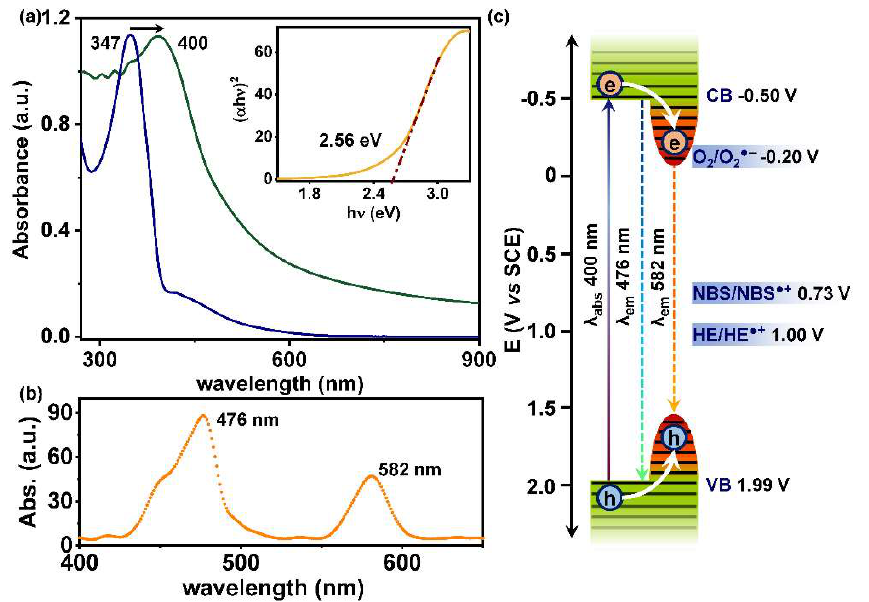
Figure 3. ( a ) The UV-Vis absorption spectra of the azo-monomer (blue) and AzoCPP (green) demon- strating the redshift in absorption maxima and corresponding Tauc plot (inset); ( b ) fluorescence spectrum of the polymer showing standard and defect-induced emission; and ( c ) schematic depiction of the entire photon absorption and emission scenario with VB-CB shown in green and defects shown in red shading.